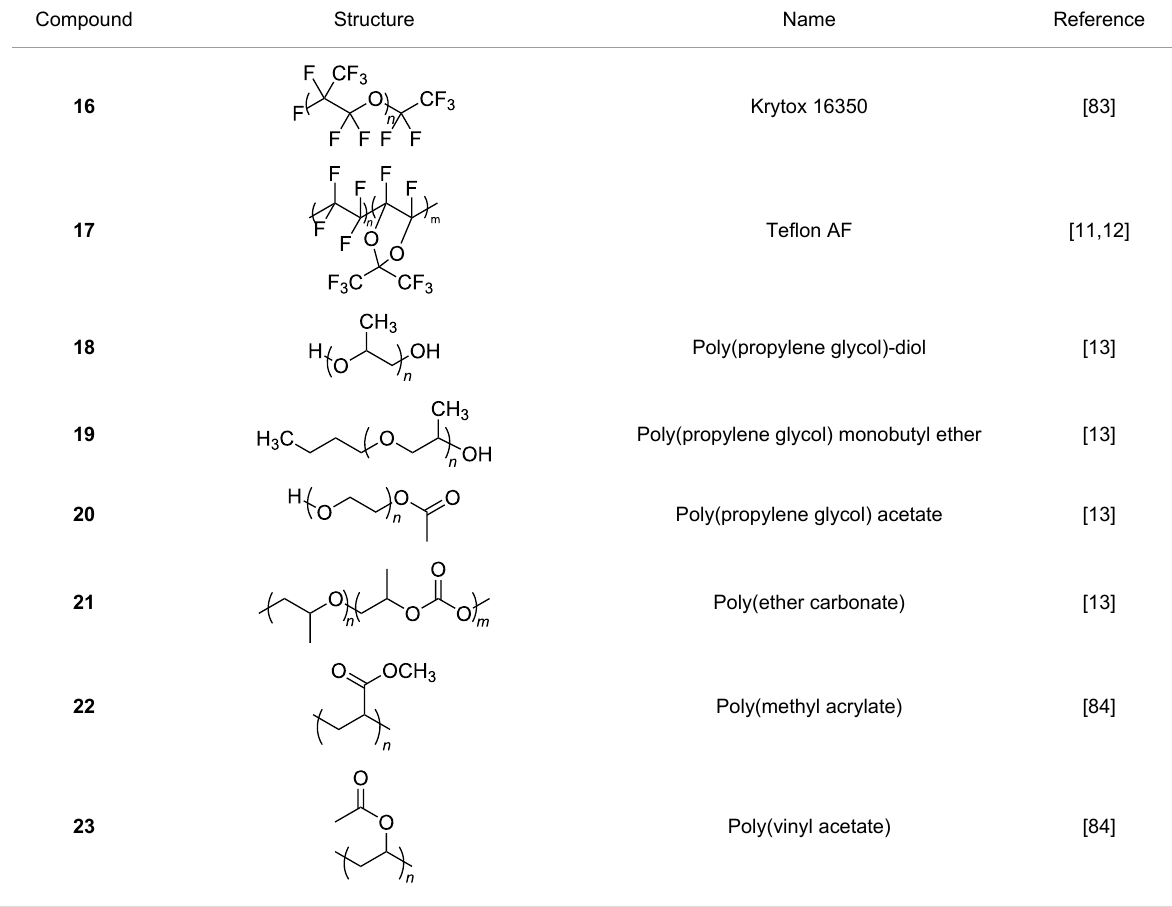
Table 2: Structures of CO 2 -philic polymers discussed in this